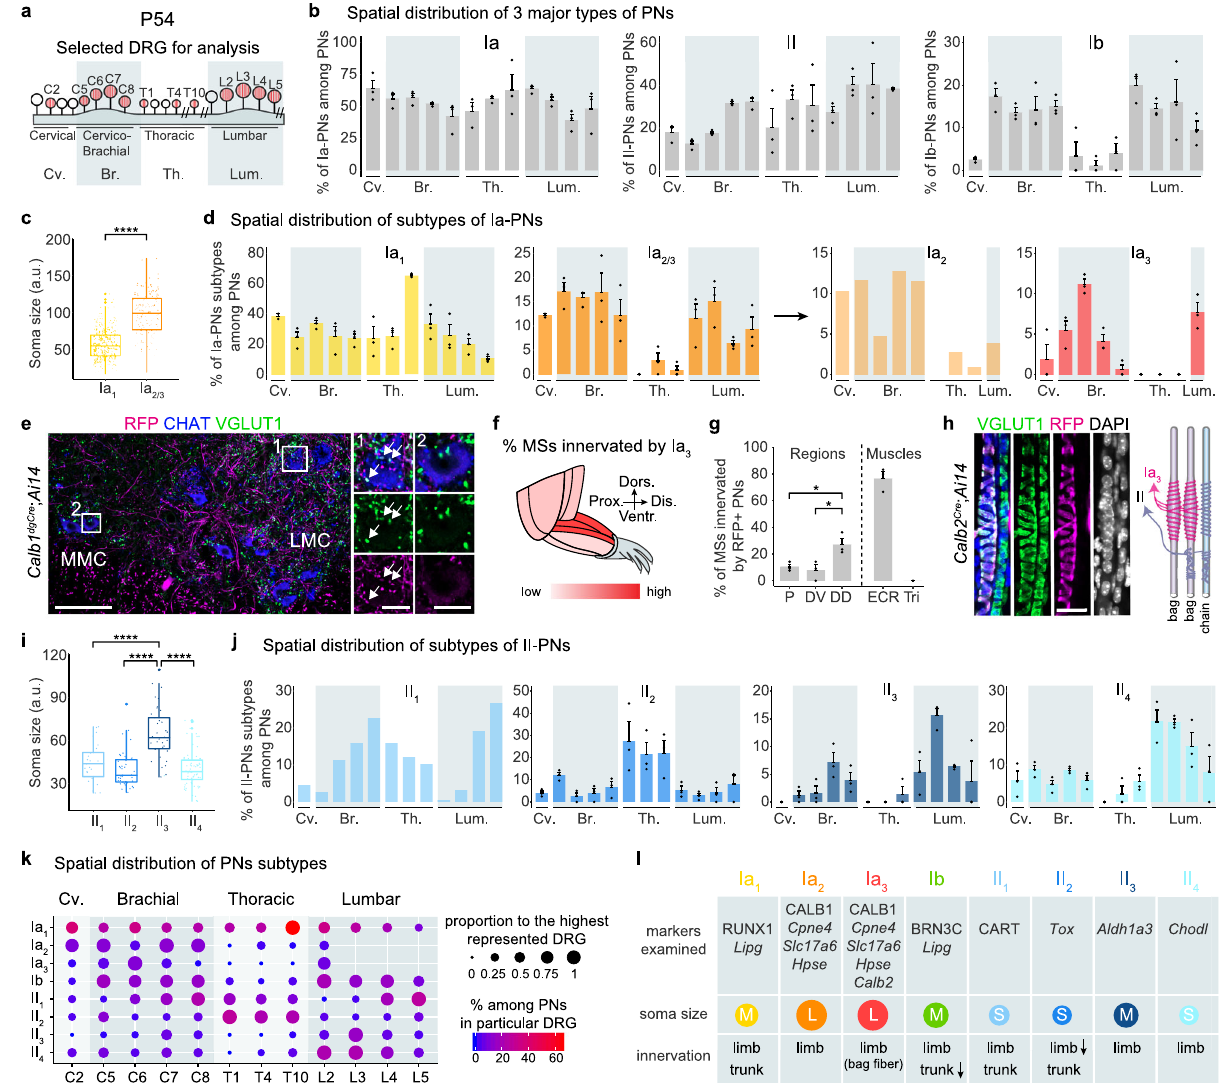
Fig. 3 Functional subdivisions of PNs. a Schematic depiction of the selected DRG (highlighted in red) to study the spatial distribution of PNs along the rostral-caudal axis of the trunk. b Spatial distribution of the three major types of PNs in representative DRG (see A) ( n = 3 animals). Data are presented as mean ± SEM; dots represent values from individual animals. See “ Methods ” for details. c Comparison of cross-nucleus soma sizes of Ia-PNs subtypes depicted in box and whisker plot. Lower and upper hinges: fi rst and third quartiles; the horizontal line: median; the whiskers extend to the value no further than 1.5 * IQR from the hinge; large dots: outliers. Each small dot represents a cell: Ia 1 ( n = 342 cells), Ia 2 and Ia 3 together ( n = 148 cells). Two-tailed t -test, **** p < 0.0001. d Spatial distribution of Ia-PNs subtypes in representative DRG (see A). Data are presented as mean ± SEM ( n = 3 animals); dots represent values from individual animals. See Methods for details. e Ventral spinal cord section of P54 Calb1 dgCre ;Ai14 mice labeled for CHAT (motor neurons) and VGLUT1 (sensory terminals), showing RFP + sensory boutons onto motor neurons in LMC but not MMC. Scale bar: 100 µ m. Scale bars of the micrographs: 20 µ m. f Schematic depiction of the over-representation of Ia 3 -PNs innervation in the distal-dorsal region of the mouse forelimb. g Proportion of MSs innervated by RFP + afferents in P30 Calb2 Cre ; Ai14 mice ( n = 3 animals). P: proximal; DD: distal-dorsal; DV: distal-ventral; ECR: extensor carpi radialis; Tri: triceps. Data are presented as mean ± SEM; dots represent values from individual animals. Two-tailed t -test, * p < 0.05. h MS of P30 Calb2 Cre ;Ai14 mice stained for RFP, VGLUT1 and DAPI, showing that RFP + afferents innervate only the nuclear bag but not chain fi bers. Bag and chain fi bers are distinguishable by their sizes and organization of nuclei: chain fi bers have nuclei aligned in a chain, while bag fi bers have many nuclei stacked in bags. Right panel: schematic representing the fi nding. Scale bar: 20 µ m. i Quanti fi cation of cross-nucleus soma sizes of II-PNs subtypes depicted in box and whisker plot. Lower and upper hinges: fi rst and third quartiles; the horizontal line: median; the whiskers extend to the value no further than 1.5 * IQR from the hinge; large dots: outliers. Each small dot represents a cell: II 1 ( n = 25 cells), II 2 ( n = 43 cells), II 3 ( n = 37 cells), II 4 ( n = 65 cells). Two-tailed t -test, **** p < 0.0001. j Spatial distribution of II-PNs subtypes in representative DRG (see a). Data are presented as mean ± SEM ( n = 3 animals); dots represent values from individual animals. See “ Methods ” for details. k Dot plot summarizing the spatial distribution of all PN subtypes. The size of the circle re fl ects how a subtype is distributed along the rostro-caudal axis where the presence of the subtype in each DRG is proportional to the highest represented DRG. The color intensity re fl ects the percentage of different subtypes among all PNs in the same DRG. l Table summarizing main characteristics of PN subtypes. The illustrated soma sizes of the subtypes are proportional to the average soma sizes of the respective PN subtypes observed in situ. Source data are provided as a Source Data fi le.